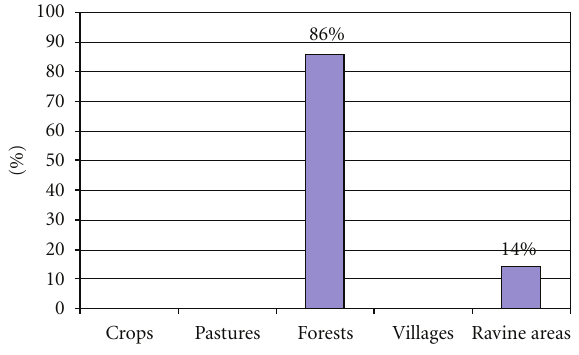
Figure 5: Preferred patches of landscape.